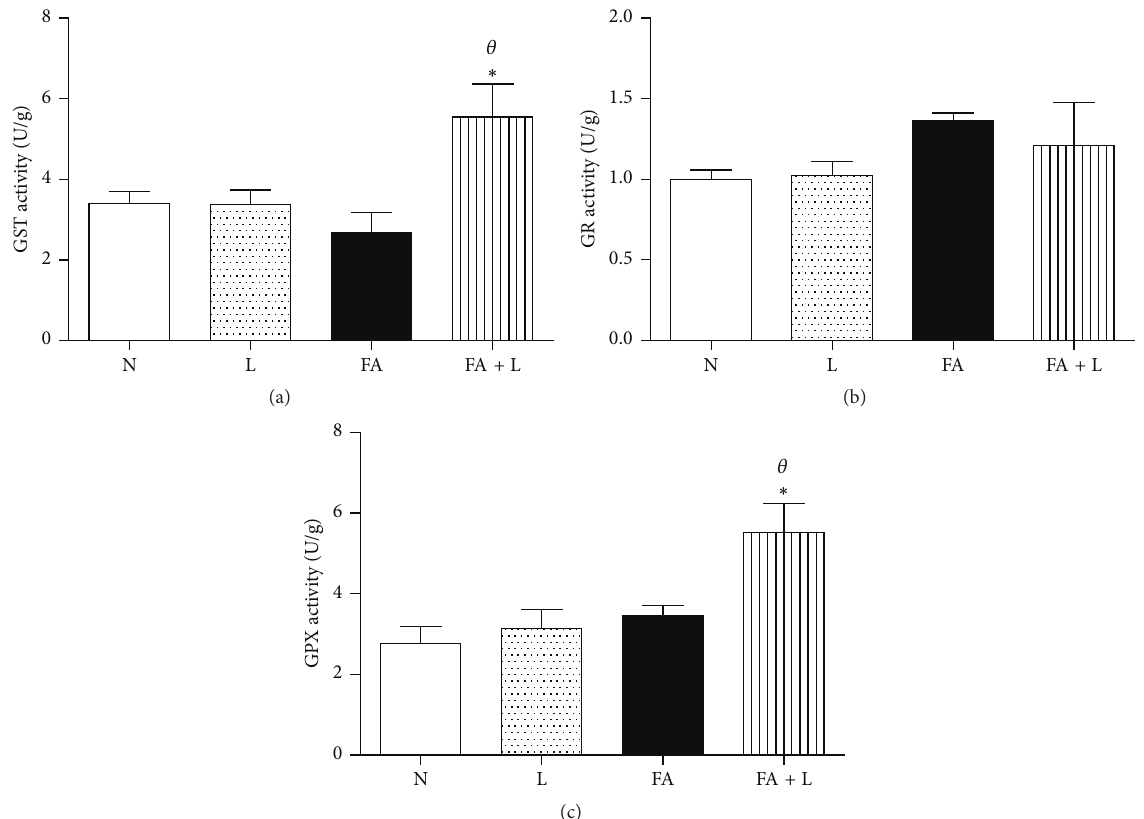
Figure 5: Photobiomodulation therapy increases activity of glutathione s-transferase and peroxidase enzymes after FA exposure in the lung. Group of rats was exposed to FA inhalation (1%, 90 min/day, 3 days) and treated or not with LLLT (30mW, 1.8J, 60 s/point, total 540 s, 1 and 5 h after each FA inhalation). In parallel, group of rats were treated only with laser and nonmanipulated rats were used to obtain basal parameters. The activities of glutathione s-transferase, reductase, and peroxidase were determined 24 h after the last FA inhalation. Data mean ± SEM of 6 animals per group. ∗ 𝑃 < 0.05 in relation to N, and L groups; 𝜃 𝑃 < 0.05 in relation to FA